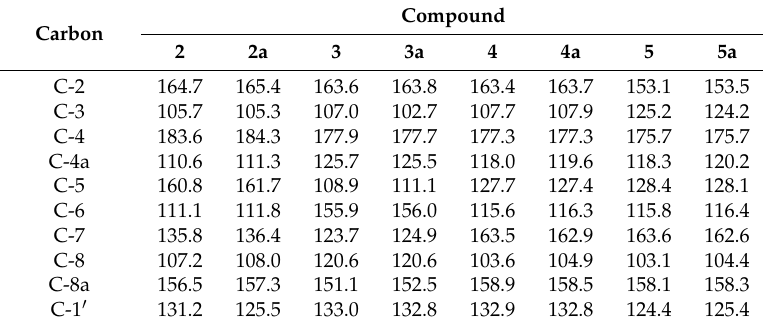
Table 4. 13 C-NMR shifts ( δ ) of 5-hydroxyflavone ( 2 ), 6-hydroxyflavone ( 3 ), 7-hydroxyflavone ( 4 ) and 4 (cid:48) ,7-dihydroxyisoflavone (daidzein) ( 5 ) and products of their biotransformations ( 2a , 3a , 4a , 5a ) in Acetone- d 6 , 600 MHz (Supplementary